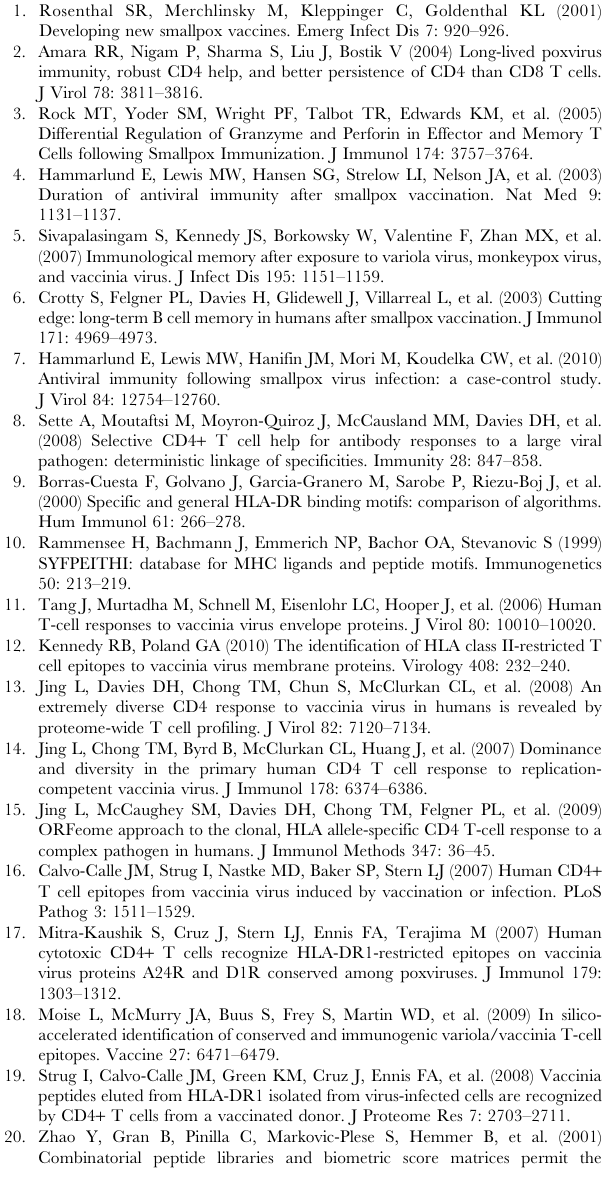
Figure S1 HLA restriction of peptides and vaccinia